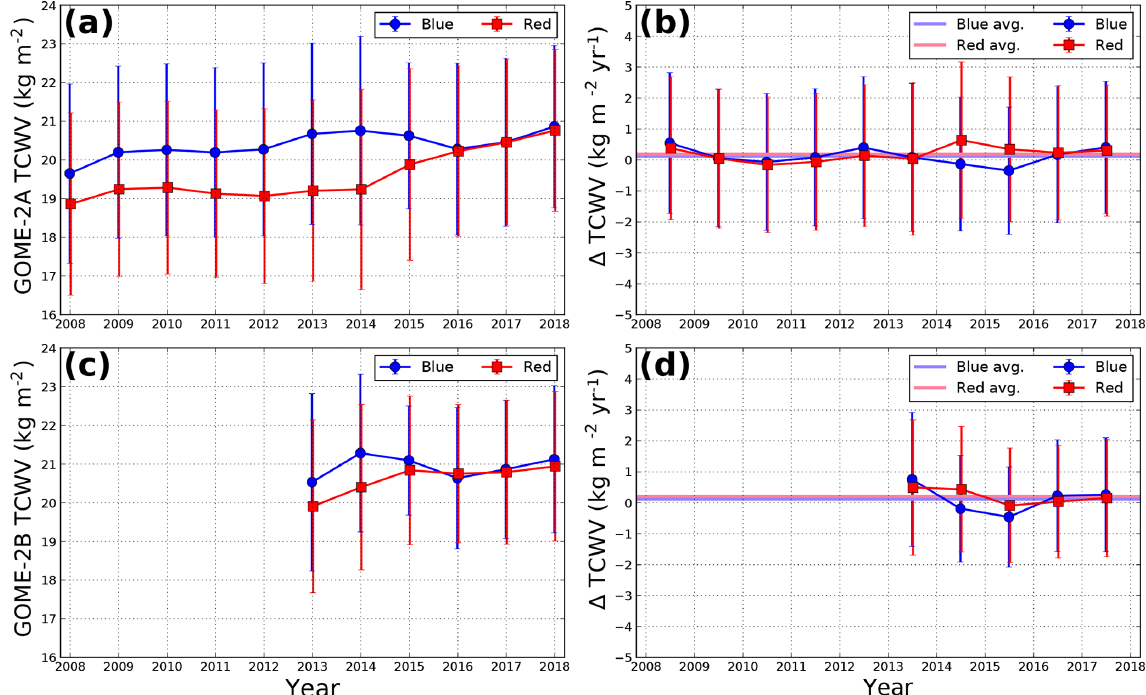
Figure 11. Time series of annual average of TCWV retrieved from (a) GOME-2A and (c) GOME-2B in blue (blue curves) and red (red curve) spectral bands. The rate of change in TCWV derived from (b) GOME-2A and (d) GOME-2B is also shown. The purple and pink lines indicate the average rate of change derived from the blue and red band measurements, respectively. The error bars indicate the 1 σ standard deviation of the annual